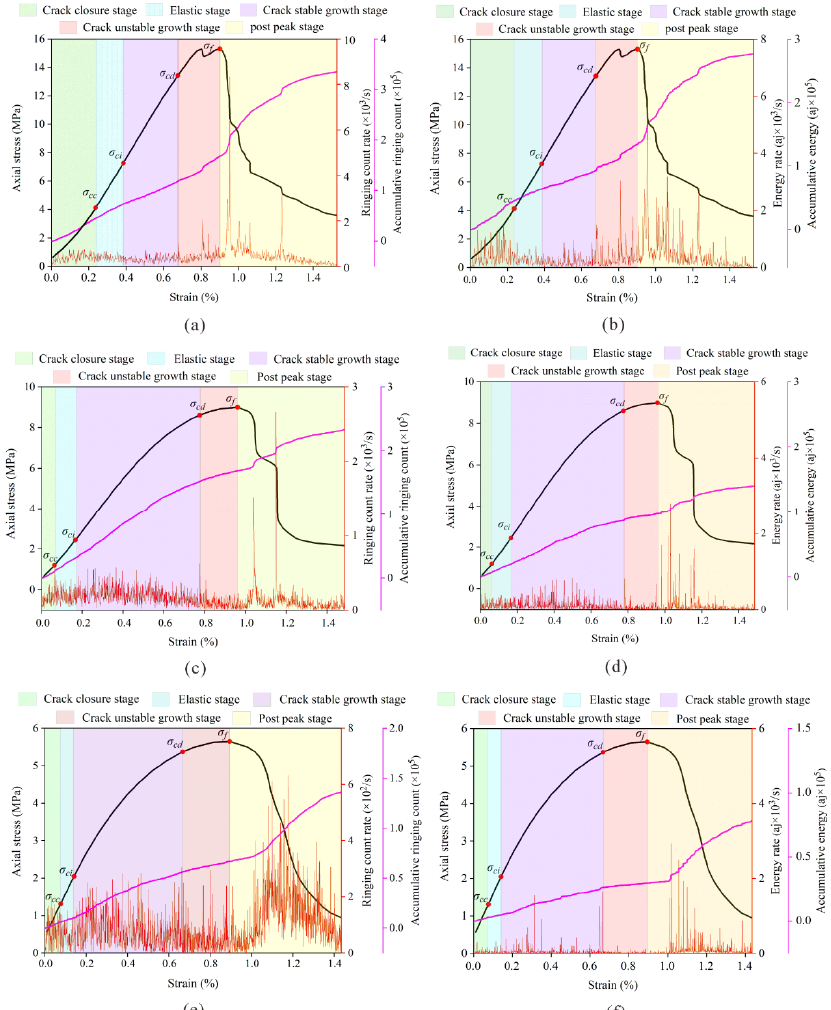
Figure 8. Variation of the AE parameters of the specimens with different brittleness indexes (4.16, 3.36, and 2.25) during different failure stages: ( a , c , e ) the ring count rate and accumulative ringing count and ( b , d , f ) the energy rate and accumulative energy.